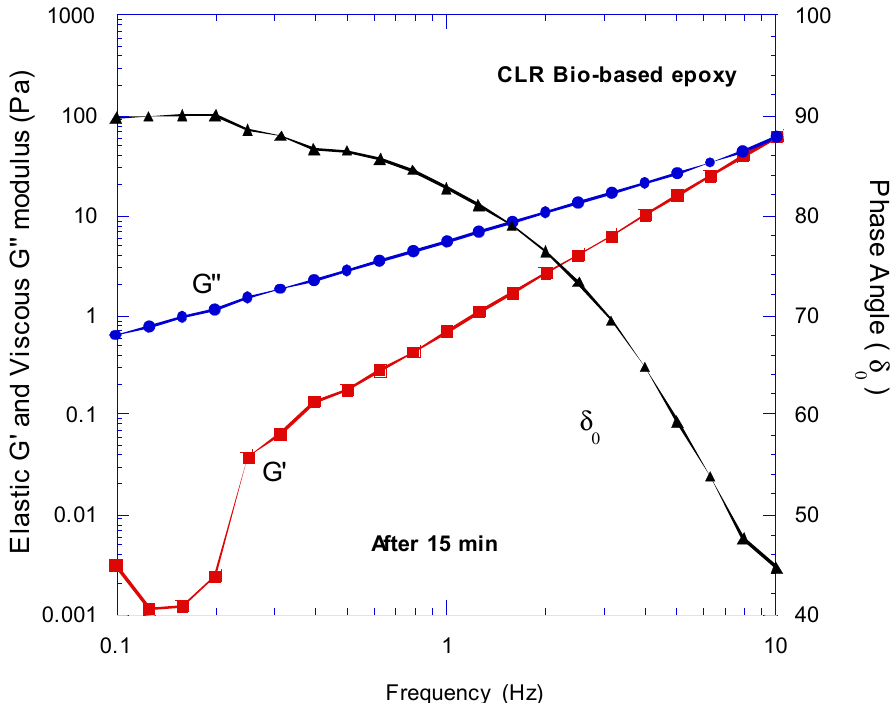
Figure 6. Frequency sweep result of CLR epoxy 15 min after the mixing of the hardener.